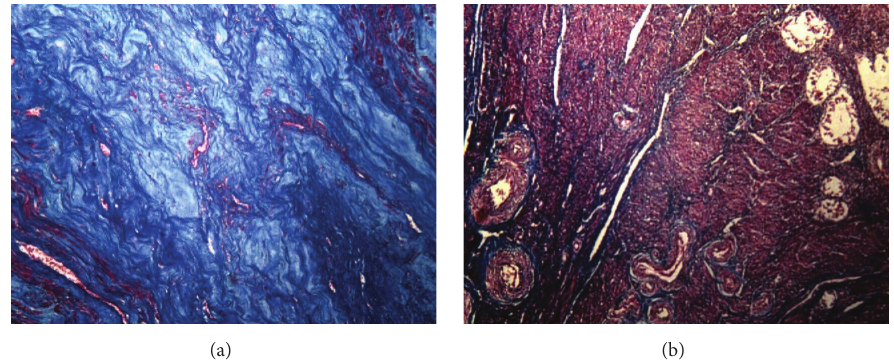
Figure 4: (a) Uterine leiomyoma. It is possible to see numerous collagen fibers of varied density and intensity (in blue). (b) Normal myometrium adjacent to the leiomyoma. Bundles of smooth muscle cells crisscrossed and arranged in fascicles (in red). Staining: Masson’s trichrome. Magnification: